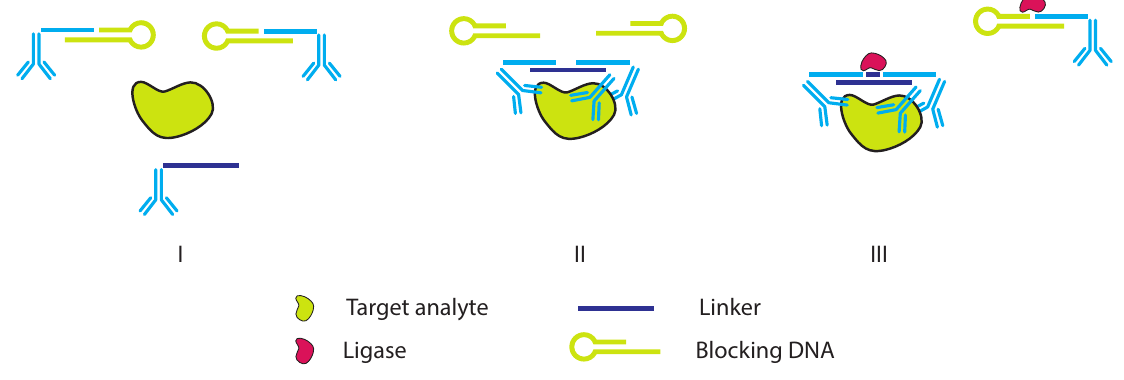
Figure 12. The triple PLA. ( I ) Free proximity probes are blocked using partially complementary hairpin probes. ( II ) The target protein is recognized by three proximity probes simultaneously, each targeting a different epitope. The blocking hairpins are displaced by a linker ssDNA. ( III ) Ligase is used to merge the affinity probe ssDNA moieties and linker ssDNA and unbound affinity probes are simultaneously locked with blocking hairpins. Subsequent detection of the linked probes can be achieved using qPCR [50].